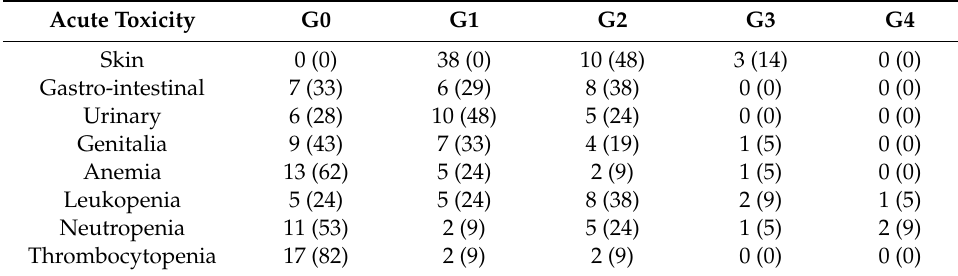
Table 4. Acute toxicity profile.